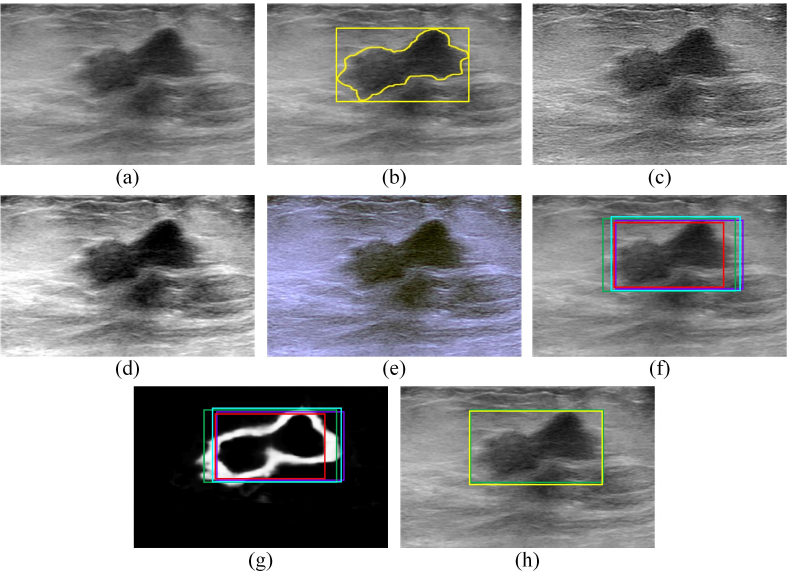
Figure 4. ( a , b ), the ( a ) A malignant BUS image and ( b ) the corresponding gold standard tumor outline (yellow outline) and gold standard ROI (yellow box) that contains the tumor. ( c – e ) The ( c ) sharpened image, ( d ) contrast-enhanced image, and ( e ) artificial RGB image computed for the B-mode image presented in ( a ). ( f ) The ROI localizations generated by the Faster R-CNN (violet box), SSD (red box), EfficientDet-D0 (cyan box), and CenterNet (green box) models overlaid on the BUS image. ( g ) The ROI localizations generated by the Faster R-CNN (violet box), SSD (red box), EfficientDet-D0 (cyan box), and CenterNet (green box) models overlaid on the edge map. ( h ) The ROI selected by the proposed edge-based selection method (in this case, the ROI generated by the CenterNet model—green box) as well as the gold standard tumor outline (yellow box) overlaid on the BUS